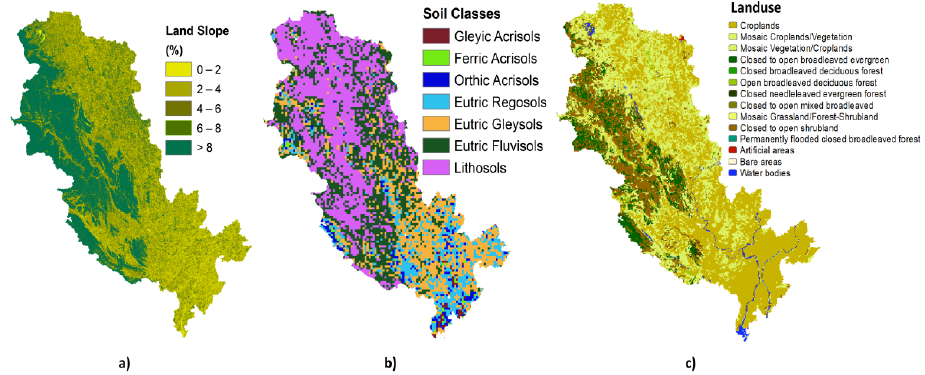
Figure 2. ( a ) Land slope, ( b ) Soil classes and ( c ) Land use maps used in Soil Water Assessment Tool (SWAT) to determine the Hydrological Response Unit